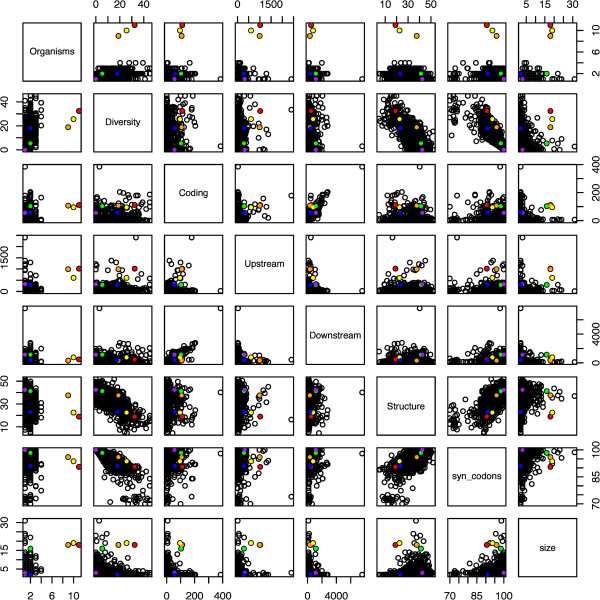
Correlations between cluster features. Each cluster is represented as a point in each of the panels. Each panel shows the correlation between a pair of feature values. Known pyrrolysine gene clusters are marked with colors: mttB (red), mtbB (orange), mtmB (yellow), transposase1 (green), transposase2 (blue) and TetR (purple). Unknown clusters are white. Feature combinations with discriminatory potential display significant separation between the bulk of white clusters (the majority of which are false positives) and the colored clusters (true positives). A separation is apparent in panel 4.3 which shows the combination of the fcoding and fupstream features.